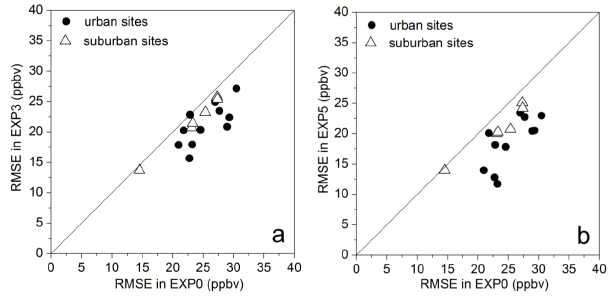
Fig. 7. Comparison of (a) RMSE of 1-h ozone forecast at urban sites (dots) and suburban sites (triangles) in free run against those in EXP3 and (b) against those in EXP5.